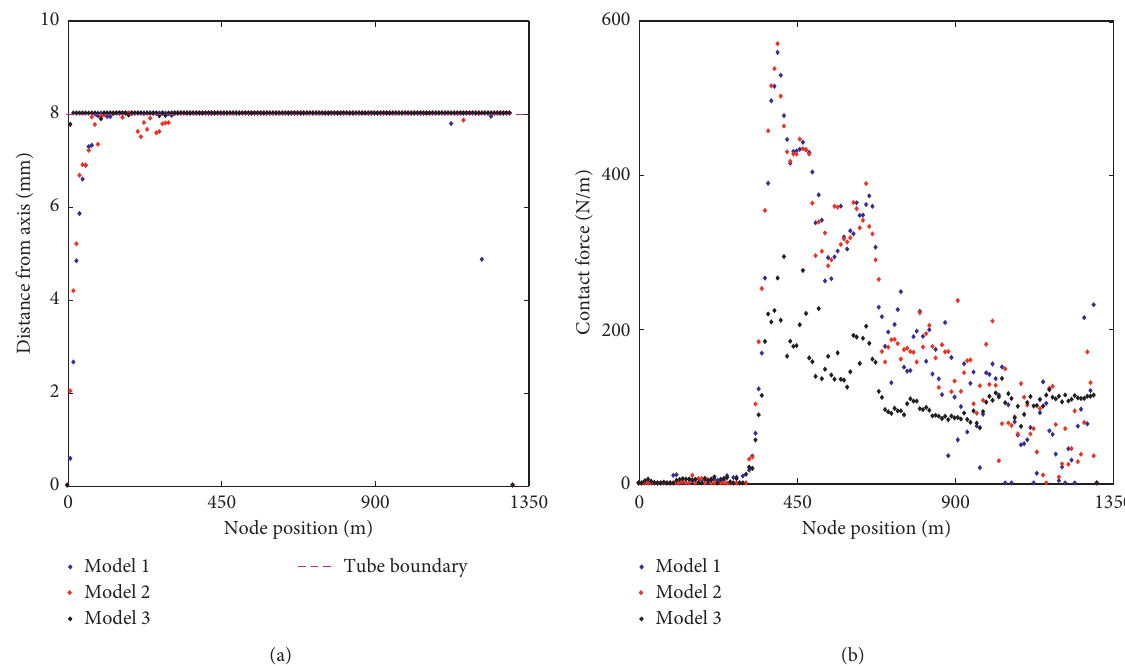
Figure 8: The coupling node simulation results at 9s. (a) Distance between node position and borehole axis. (b) Contact force between the rod and tube.